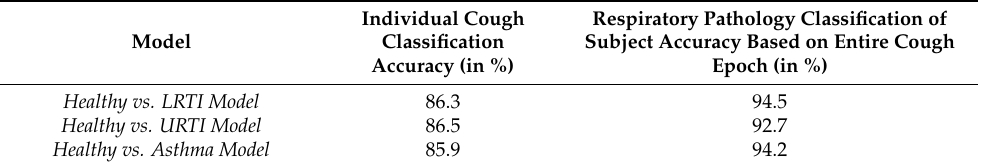
Table 5. Experimental results in terms of accuracy for Healthy vs. LRTI Model , Healthy vs. URTI Model , Healthy vs. Asthma Model .